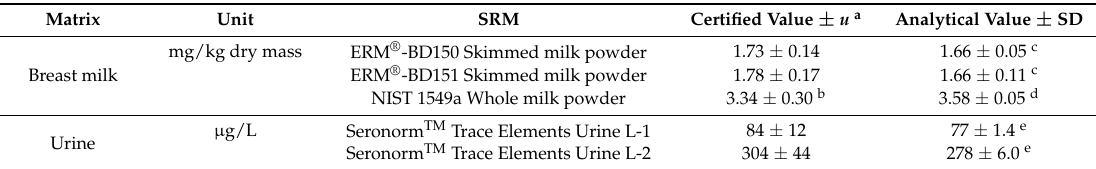
Table 1. Accuracy in the determination of iodine was checked by analysis of standard